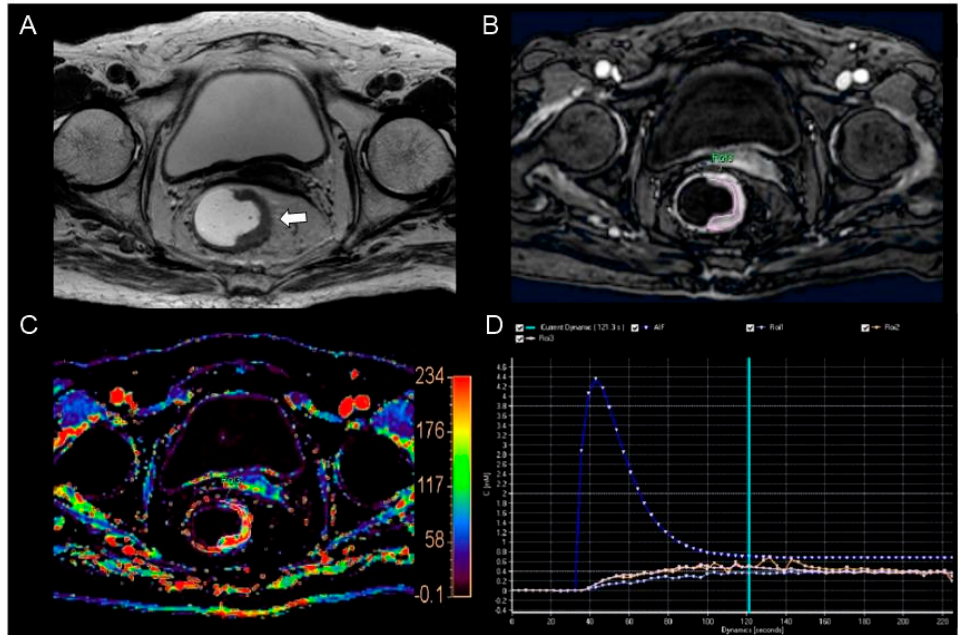
Figure 2. MR images from an 86 − year − old woman with pathologically proven well − differentiated rectal adenocarcinoma. ( A ) The T2 − weighted axial image shows an ulcero-infiltrative mass (arrow) in the left wall of the mid rectum. ( B ) The post − contrast axial 3 − dimensional spoiled gradient echo image shows a relatively hyper − enhancement in the corresponding tumor. ( C ) The color − coded K trans map shows a predominantly red color in the corresponding tumor. The calculated mean K trans was 0.137 min − 1 . ( D ) The concentration time curve shows a plot of arterial input function (AIF, blue line), which was incorporated automatically with the population − based data and three plots from the consecutive three regions of interest (ROIs − 1, 2, and 3) in the whole tumor (pale blue and orange lines).